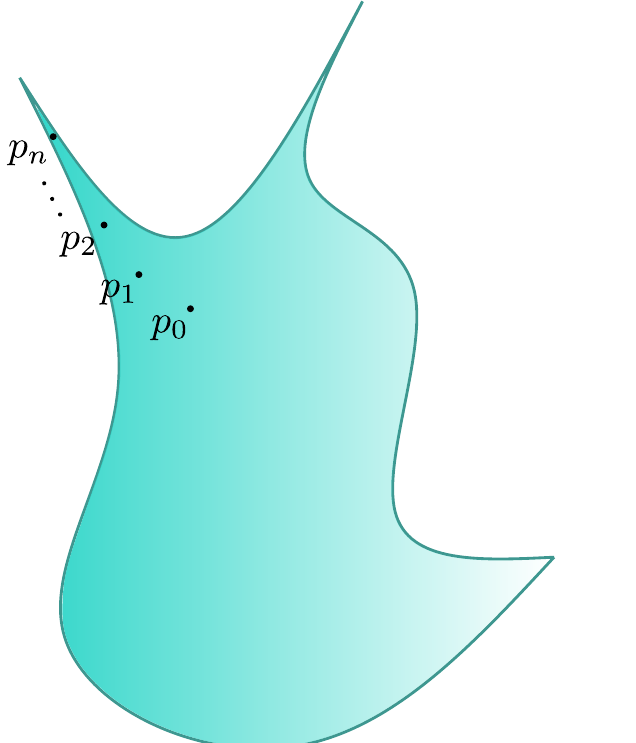
Figure 1 . A sketch of a generic moduli space with infinite-distance points. They typically correspond to weakly coupled regimes (perhaps in a dual frame), thus we start the sequence ( p n ) n ≥ 0 with p 0 already close to an infinite-distance point. More precisely, there always is an extra parameter such that the starting point is p k (cid:29) 1 , and we take the endpoint p n · k (cid:29) k to infinite distance with n → ∞ . In the models we consider in this paper, this parameter is a large rank N (cid:29) 1 of the symmetry group, which along the sequence grows to MN (cid:29) N